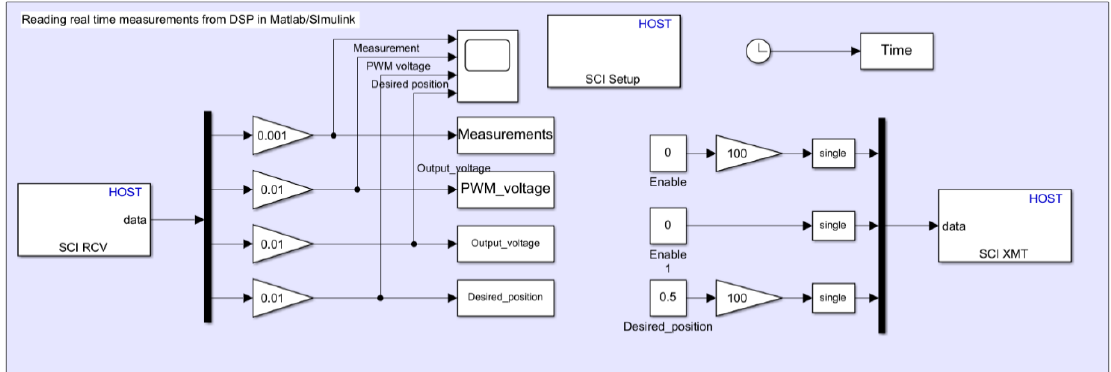
Figure 7. Reading real time measurements from DSP in Matlab/Simulink.